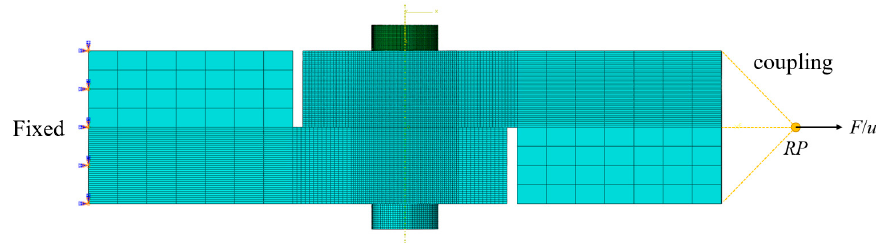
Figure 11. Initial and boundary conditions.